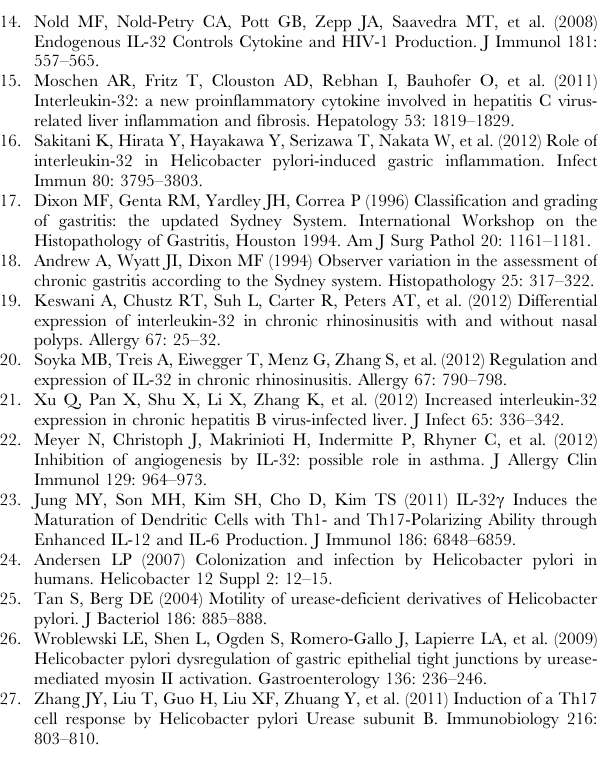
Figure S2 H. pylori strain 26695 were grown on